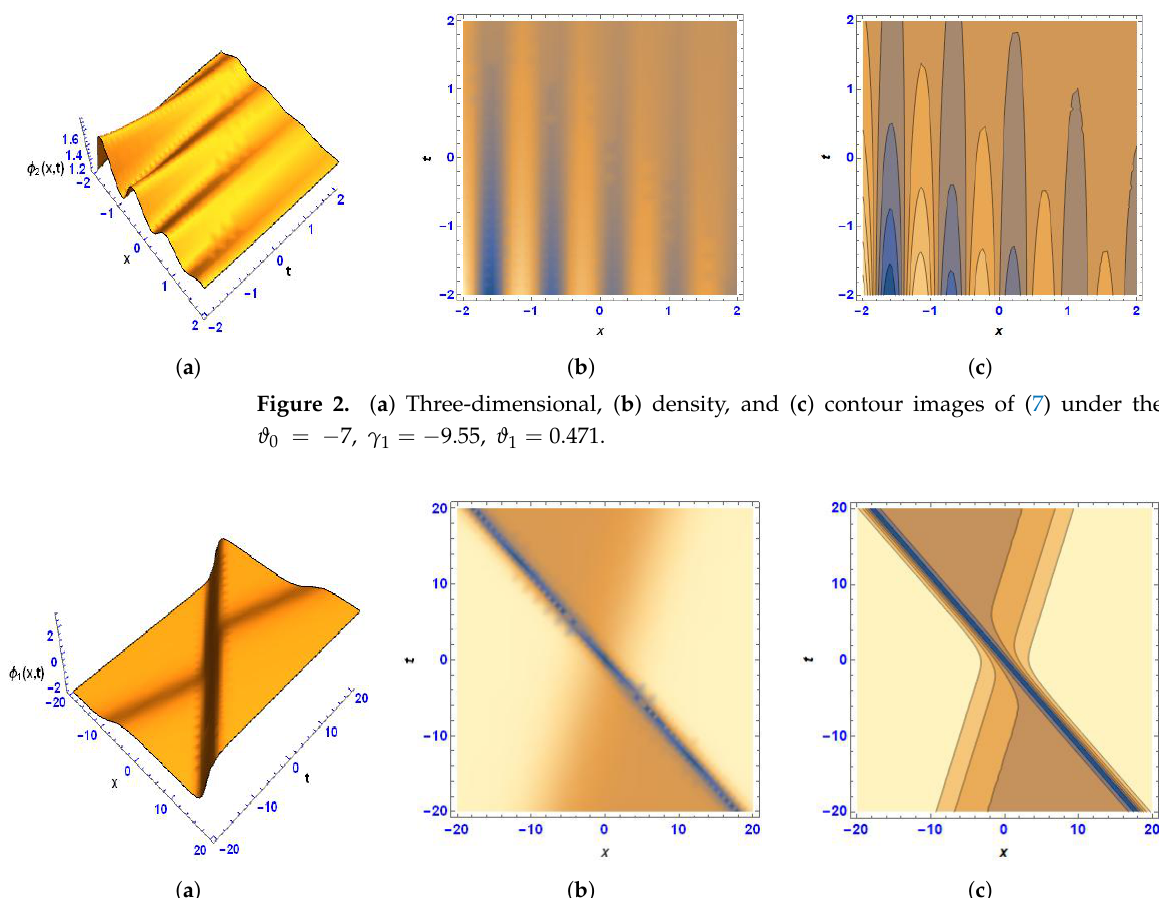
Figure 3. ( a ) Three-dimensional, ( b ) density, and ( c ) contour images of (10) under the values ϑ 5 = − 1, τ 3 = 18.5.